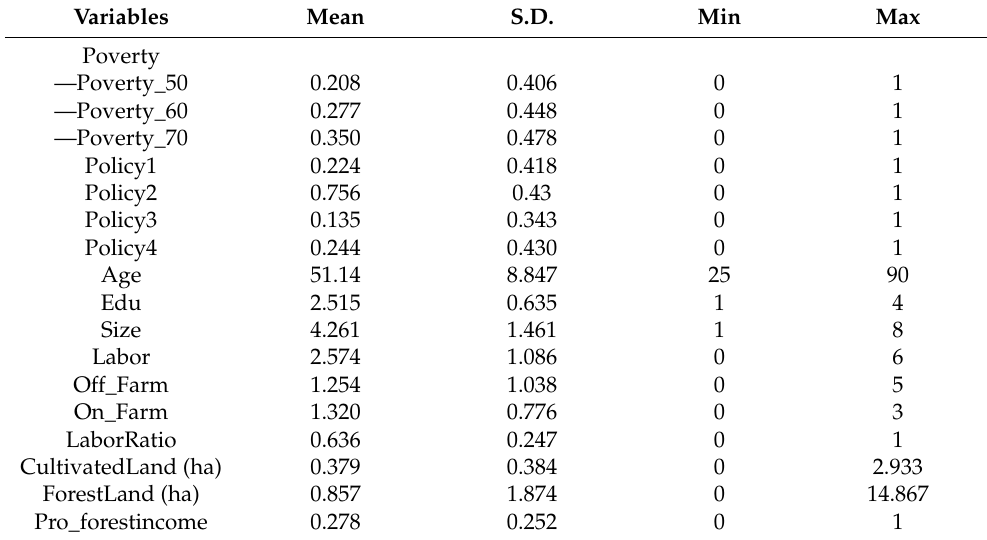
Table 4. Basic statistical indexes of